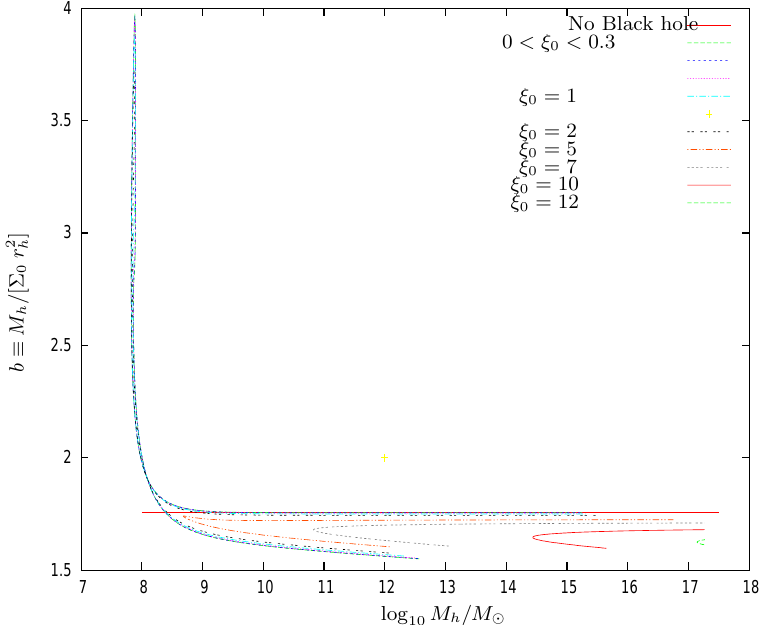
Figure 11. The scaling amplitude b M h / [Σ 0 r 2 h ] as a function of the halo mass M h . Except for halo masses near the minimum halo mass M min h Equation (83), b in the presence of a central black hole takes values up to 10% below its value 1.75572 in the absence of a central black hole Equation (85). The continuous red horizontal line b = 1.75572 corresponds to galaxies without central black holes (Equation (85)).